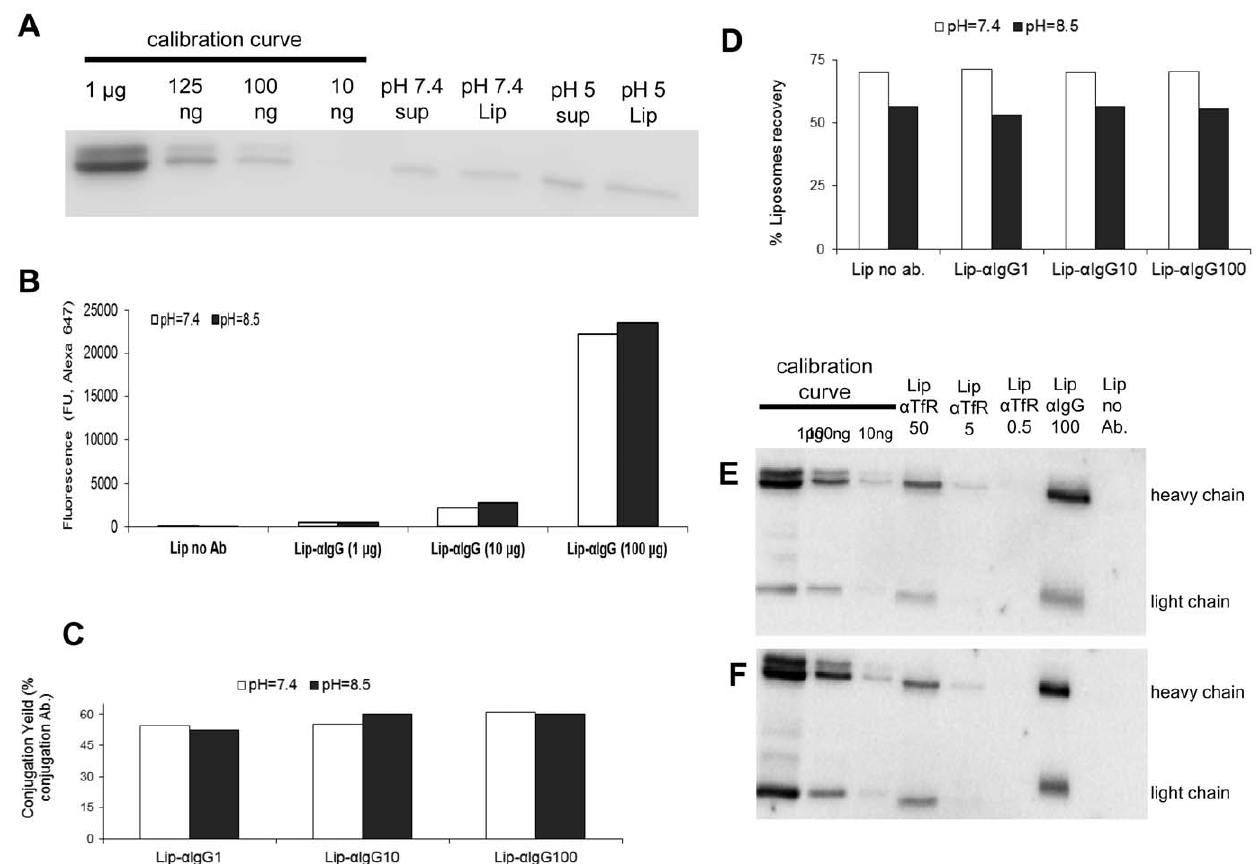
Figure 1. Optimization of anti-TfR conjugation to the liposomes. (A) Identifying the optimal pH (5 or 7.4) for the imunoliposomal preparation by Western blot analysis; (B) Fluorescence measurements of Alexa 647 (anti IgG) at different concentrations (1, 10,100 m g) conjugated to liposomes in pH=7.4 or pH=8.5; (C) Fluorescence assessments of the conjugation yield of the anti IgG antibodies to the liposomes at pH=7.4 or pH=8.5; (D) Recovery of liposomes after ultracentrifugation following antibody conjugation reaction at pH=7.4 or pH=8.5; (E, F) Western blot analysis for anti- TfR or anti-IgG conjugated antibodies (E, upper blot) and antibody content in the supernatant (F, lower blot) after ultracentrifugation (pH=7.4).